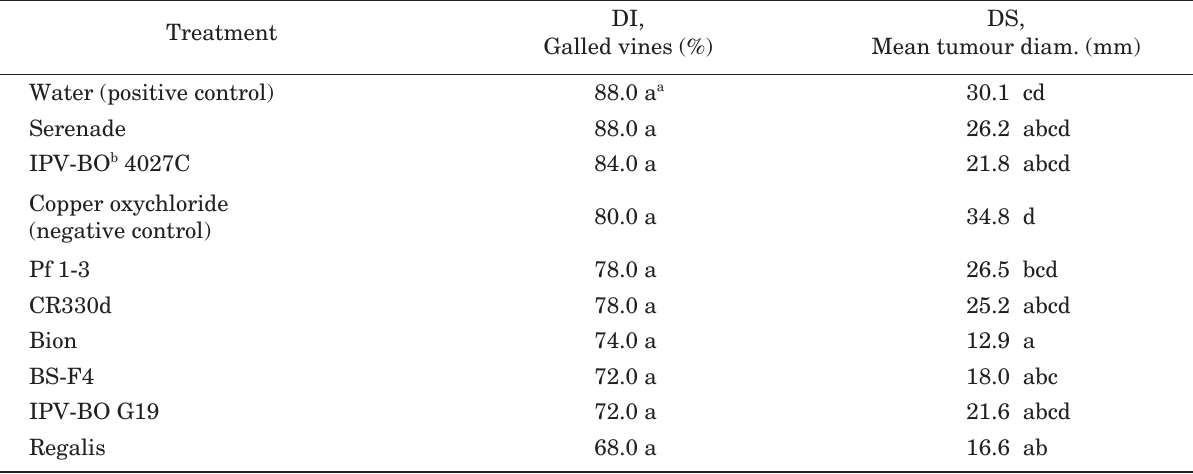
Table 2. Field experiment. Disease incidence (DI, percentage of grapevines showing tumours) and disease severity (DS, mean tumour